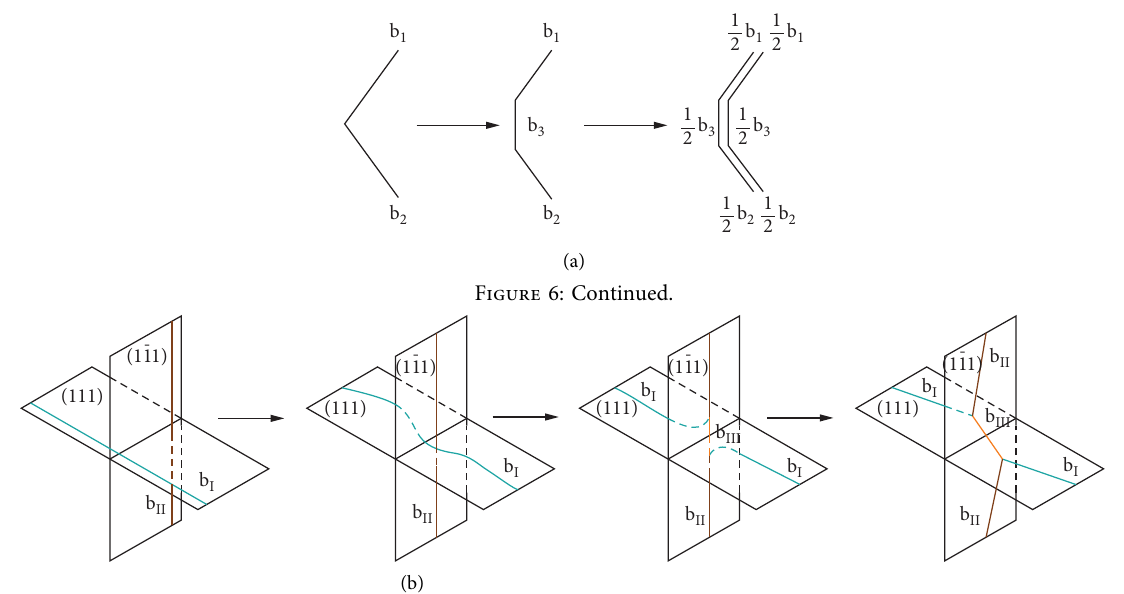
Figure 6: A schematic diagram of superdislocation formation: (a) formation of a “V”-type superdislocation node and (b) formation of an “X”-type convergent